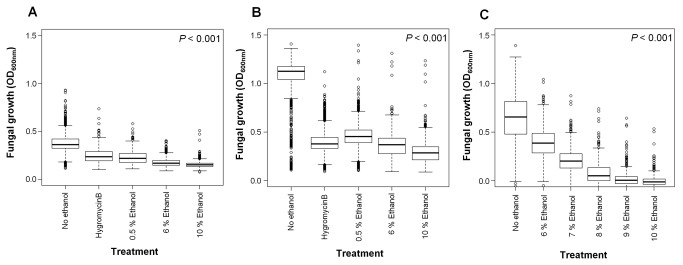
Primary and second – tier screening of putative Fusarium
oxysporum strain 11C transformants.Box and Whisker plot depicting the distribution of putative Fusarium
oxysporum strain 11C transformants (n =1,563) screened for altered ethanol tolerance during primary screening at 48 hours (A) and 96 hours (B) and transformants (n =402) screened for altered ethanol tolerance during secondary screening (C). Fungi were grown at 25°C in minimal medium [37] with five different treatments; no ethanol control; hygromycinB 60 µg ml-1 control; 0.5% (vv-1) ethanol; 6% (vv-1) ethanol; 10% (vv-1) ethanol) (Primary-tier) (A, B) or six treatments; no alcohol control; 6% (vv-1) ethanol; 7% (vv-1) ethanol; 8% (vv-1) ethanol; 9% (vv-1) ethanol; 10% (vv-1) ethanol (Second-tier) (C). Fungal growth (OD600nm) was measured after 96 hours using a spectrophotometer (Safire2, Tecan, Austria).